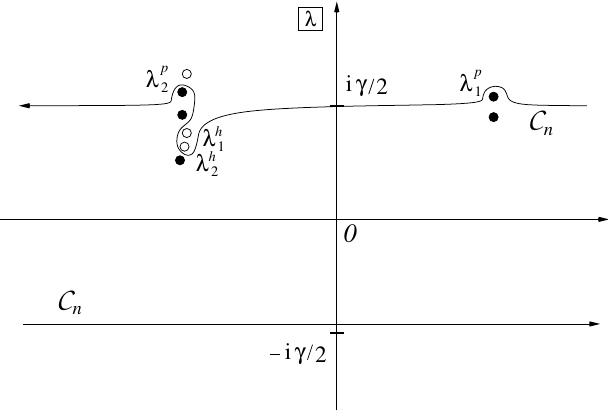
Figure 1: Sketch of the contour C . It includes the point − h R , which is close to the n NT origin for large enough Trotter number, and all Bethe roots. A few of them, the black dots, are shown in the figure. More of them are located close to the origin. The white dots depict roots of 1 + a which are no Bethe roots (so-called holes). They are all n outside C n